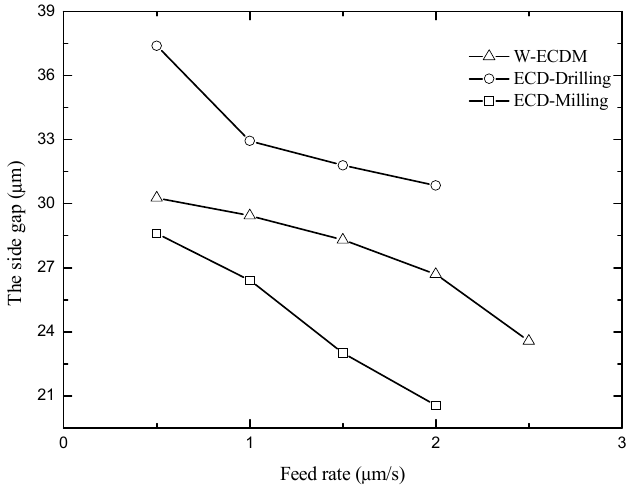
Figure 8. Effect of feed rate on side